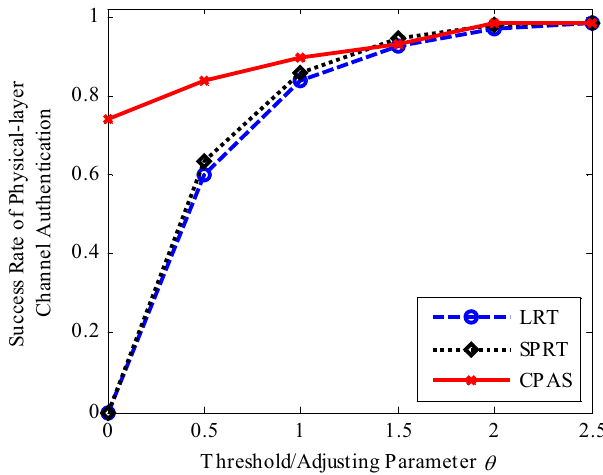
Figure 12. Success rate of physical-layer channel authentication versus threshold values or adjusting parameter θ . It shows the success rate of physical-layer channel authentication of different schemes at different θ